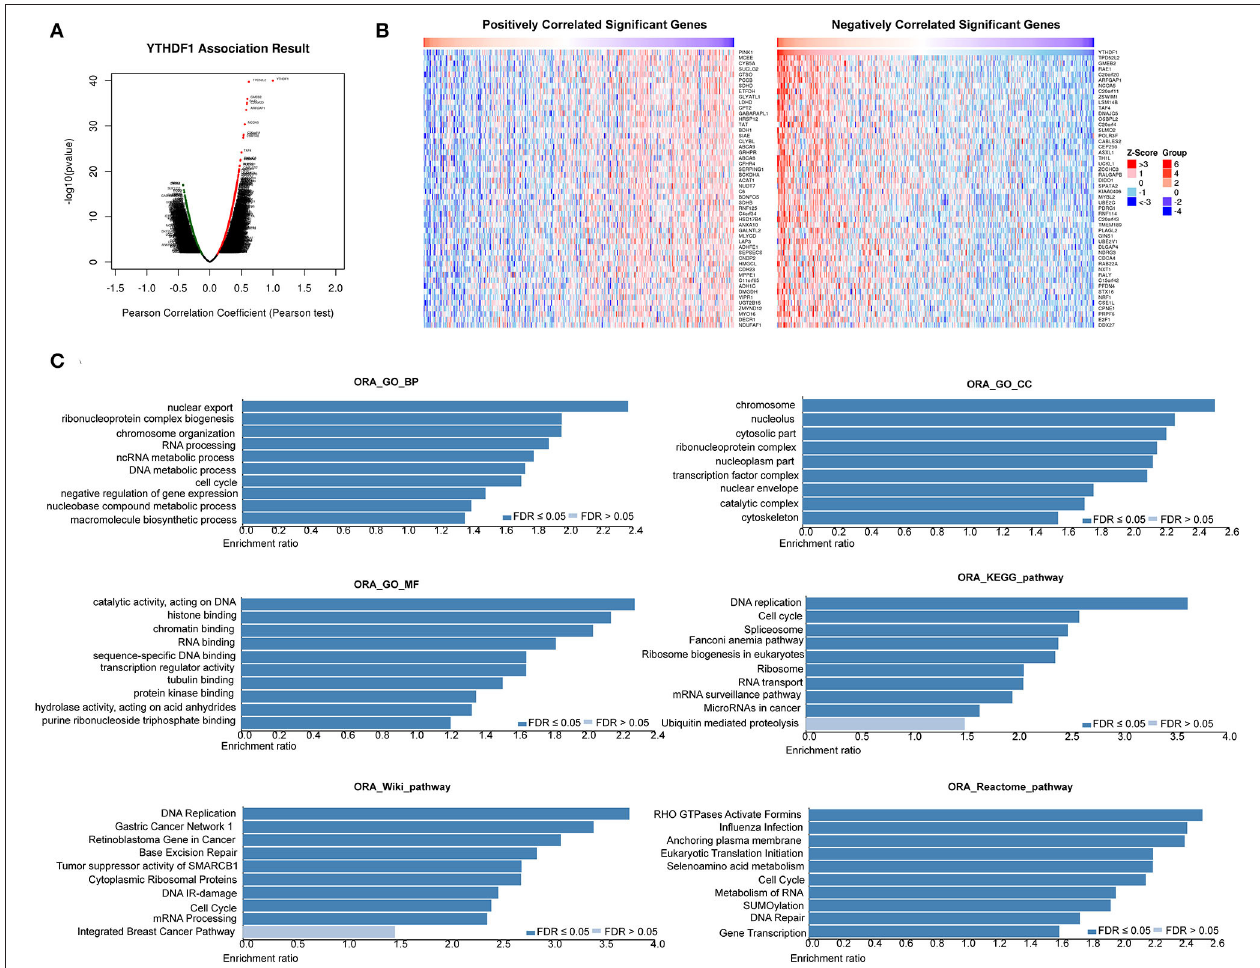
FIGURE 6 | YTHDF1 co-expression genes in hepatocellular carcinoma (HCC). (A) The global YTHDF1 significantly correlated genes in the liver hepatocellular carcinoma (LIHC) cohort were identified by LinkedOmics. (B) Heatmaps showing top 50 genes positively and negatively correlated with YTHDF1 in LIHC. Red dot, positively correlated gene; blue dot, negatively correlated genes. (C) Overrepresentation enrichment analysis of the significantly correlated genes in the LIHC